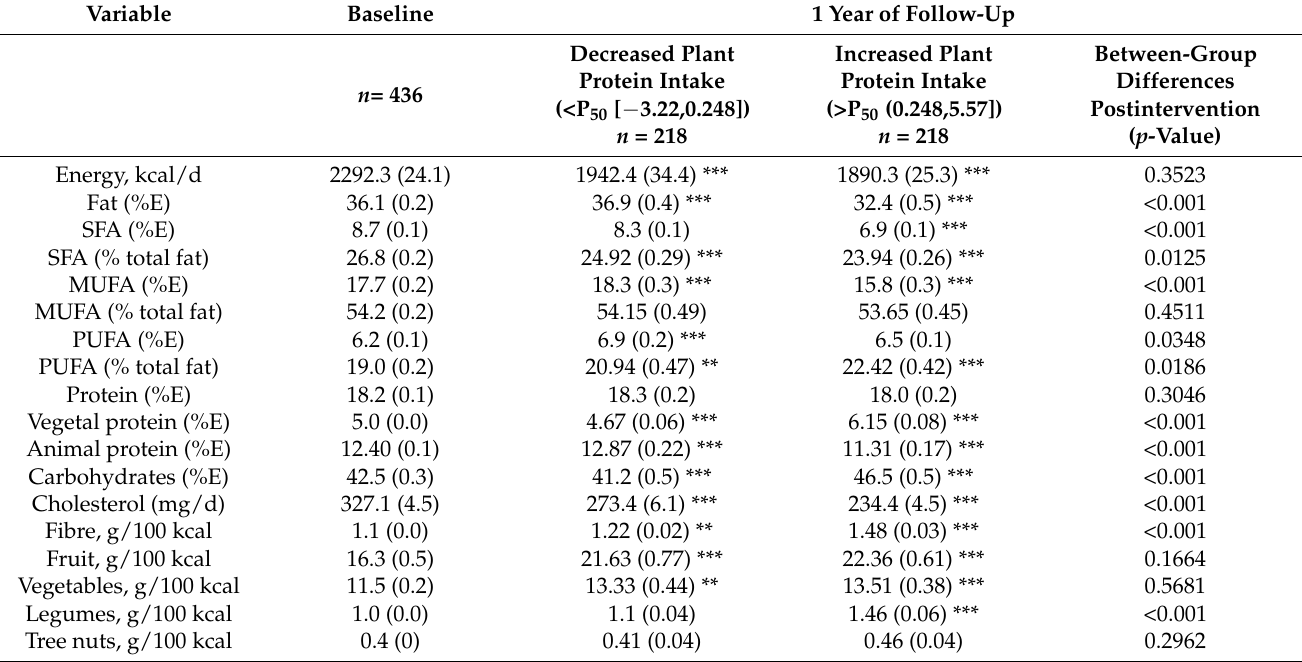
Table 2. Mean baseline and after 1 year of intervention values in energy, nutrient, and food